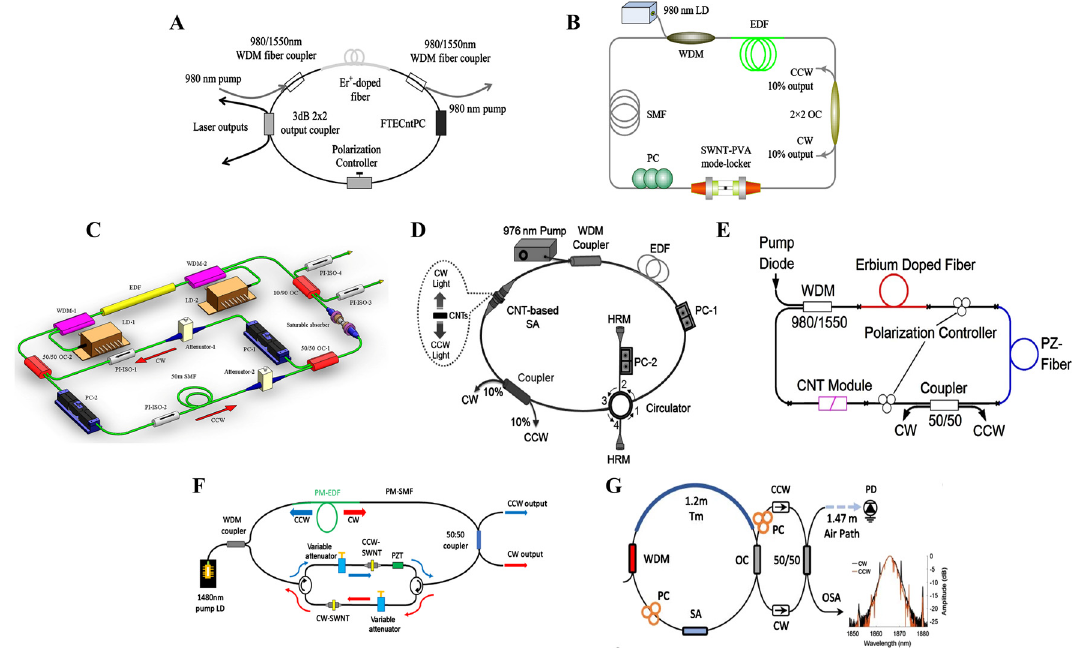
Figure 6: Typical schematic diagrams of the bidirectional fiber laser mode-locked by CNT SAs. (A) The first bidirectional mode-locked all-fiber laser with bidirectional pumping. Kieu et al. [210]. © Optical Society of America 2007. (B) A bidirectional soliton laser can obtain two stable solitons simultaneously with the same or different central wavelength. Zeng et al. [213]. © OpticalSocietyofAmerica2013.(C)Abidirectionalmode-locked fi berlaserbasedonamixtureofgrapheneandSWNTsgeneratingdissipative soliton and conventional soliton in opposite directions with intracavity attenuators. Cui et al. [214]. © Optical Society of America 2013. (D) An operation-switchable bidirectional mode-locked fi ber laser using a four-port circulator. Liu et al. [217]. © IEEE 2014. (E) A bidirectional hybrid mode-locked fi ber laser with a combination of SWNT SA and NPE. Krylov et al. [219]. © Optical Society of America 2016. (F) A bidirectional Er- doped dual-comb fi ber laser. Saito et al. [208]. © Optical Society of America 2019. (G) A bidirectional thulium-doped dual-comb fi ber laser. Olson et al. [222]. © IEEE 2018. SWNT, single-walled carbon nanotube; CNT SA, carbon nanotube saturable absorber; NPE,